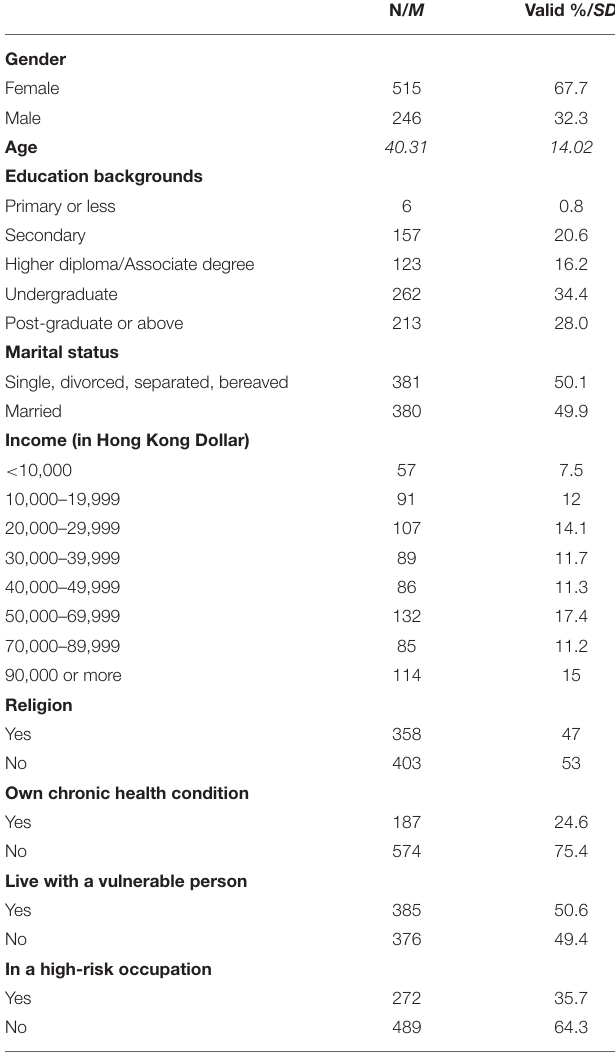
TABLE 1 | Sample characteristics ( N = 761).